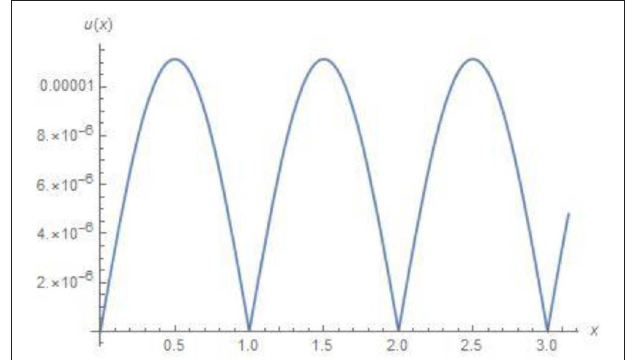
FIGURE 4 | Absolute error for TFPPDE (20) at α